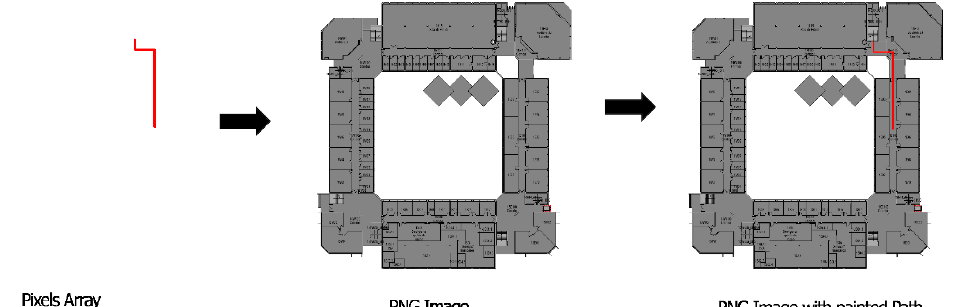
Figure 13. Floor Image View set process.